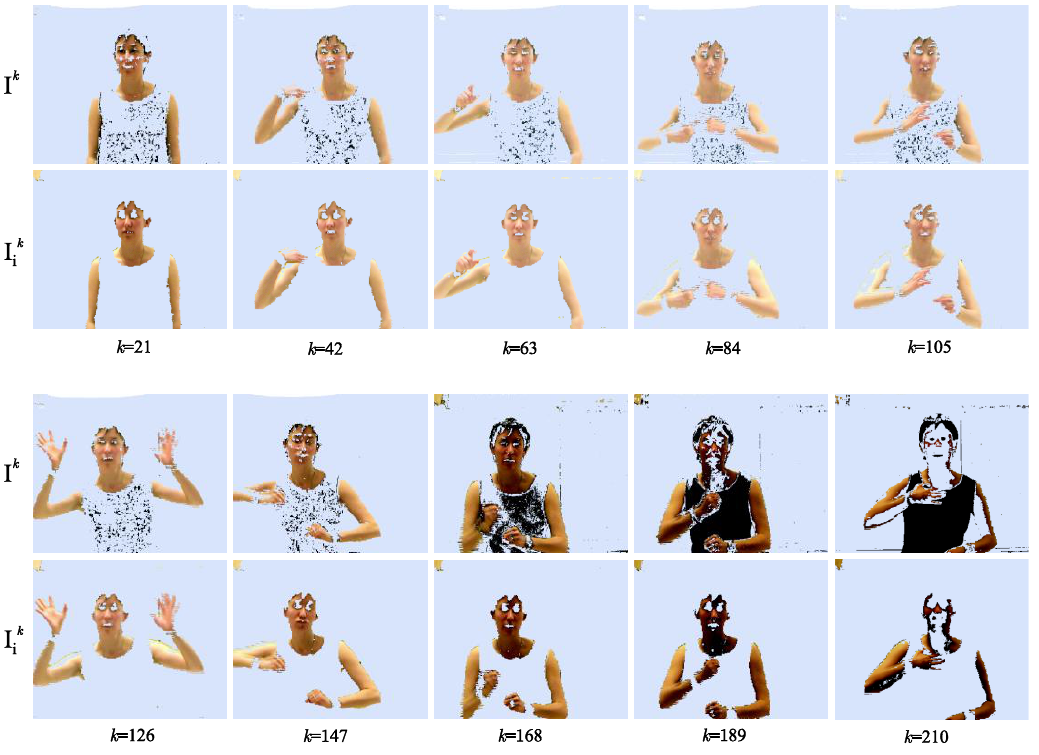
Figure 16. Segmentation results for 10 frames of an image sequence of a person generating sign language with big temporal illumination